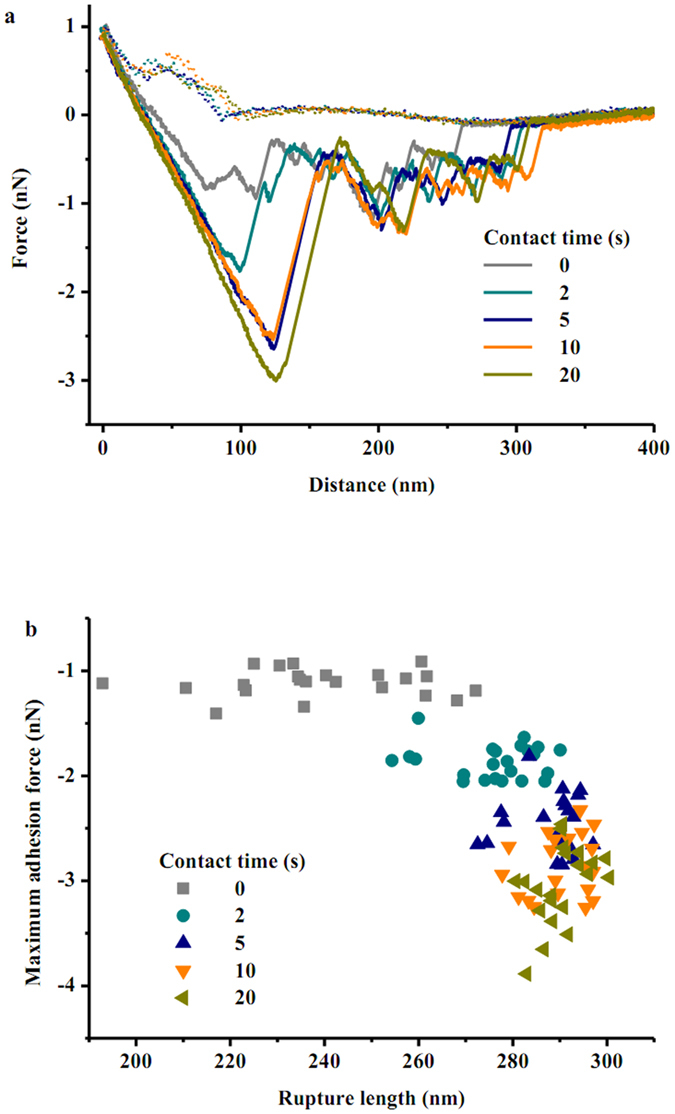
(a) Representative force-distance curves between E. coli and goethite as a function of the surface contact time in water. For each approach-retraction cycle, the upper dataset corresponds to approach values, whereas the lower dataset corresponds to retraction values. (b) The summary of the maximum adhesion forces and rupture lengths between E. coli and goethite in deionized water.